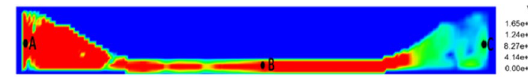
Figure 30 Distribution map of measurement